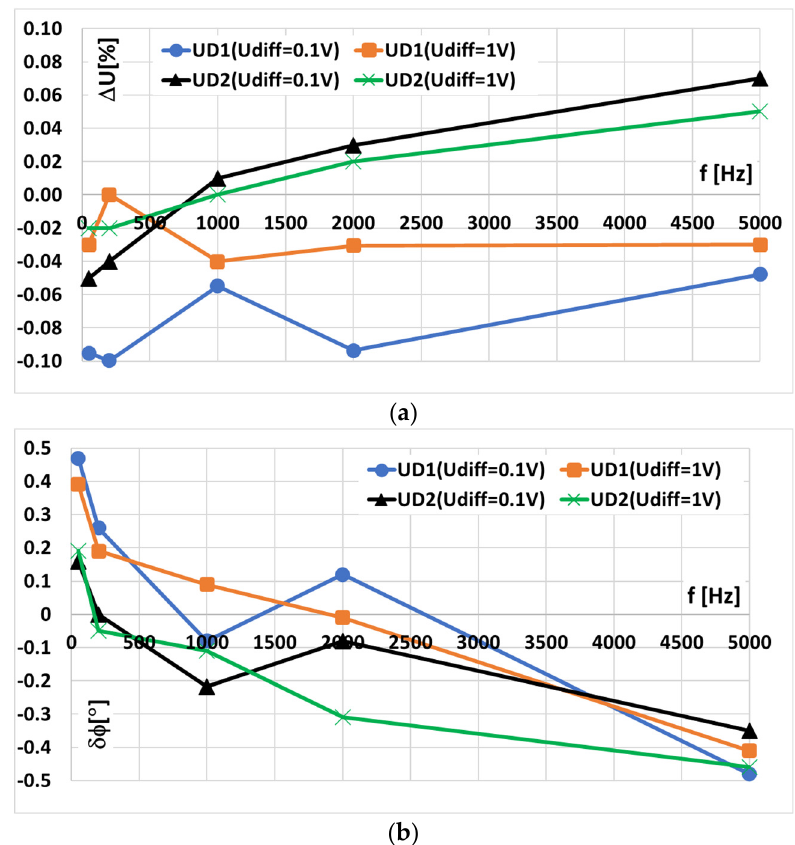
Figure 6. ( a ) The 1st and the 2nd opto-isolation circuits’ conversion ratio error under operation with- out an additional common voltage divider (input IN 2 shorted with common voltage input). ( b ) The 1st and the 2nd opto-isolation circuits’ conversion phase error under operation without an addi- tional common voltage divider (input IN 2 shorted with common voltage input).